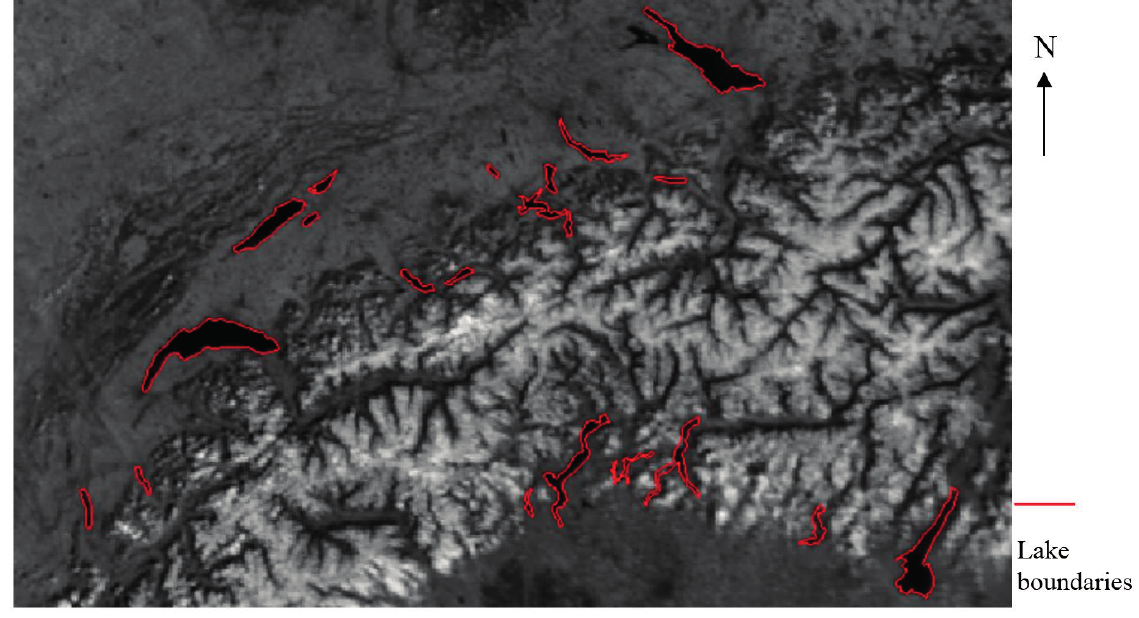
Figure 3. AVHRR Band-2 image part acquired from Metop-A on 7 May 2008 at 10:00 and the lakes used for absolute accuracy